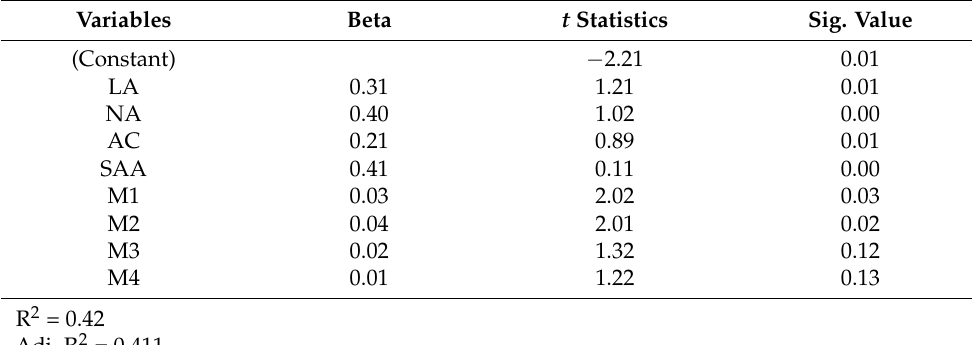
Table 10. Regression analysis of